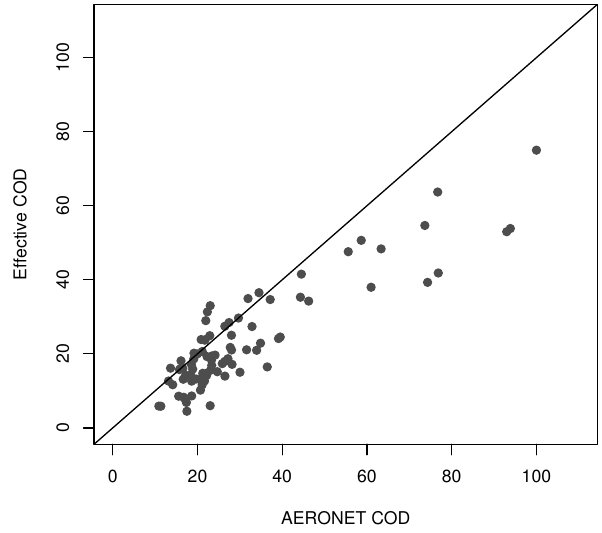
Fig. 4. Correlation between AERONET COD and effective COD values in the erythemal range. The solid black line is the zero bias line, unit